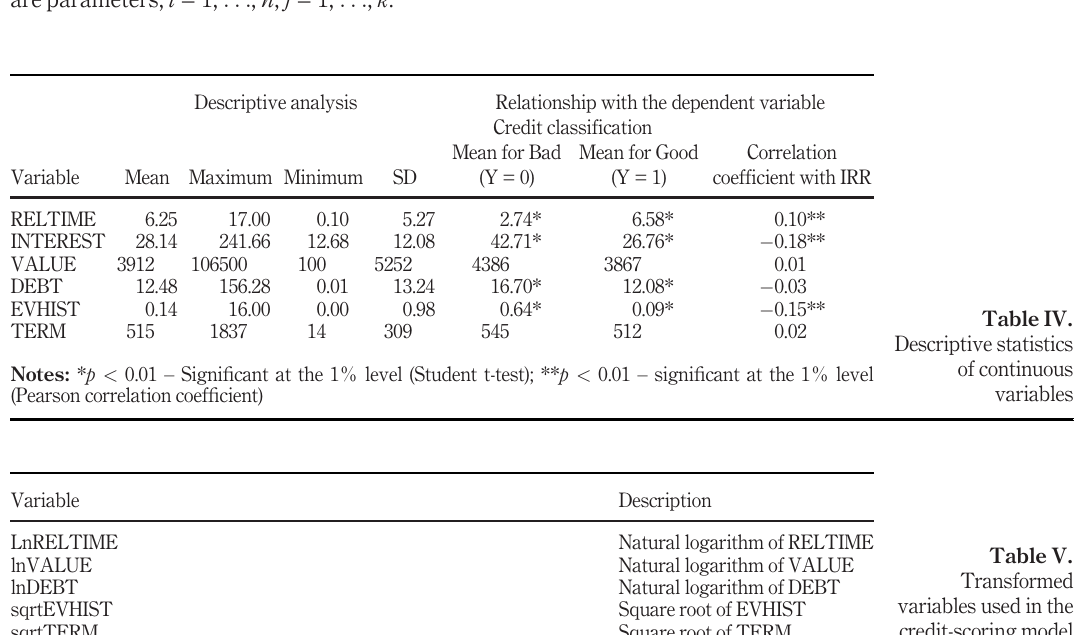
variables used in the credit-scoring